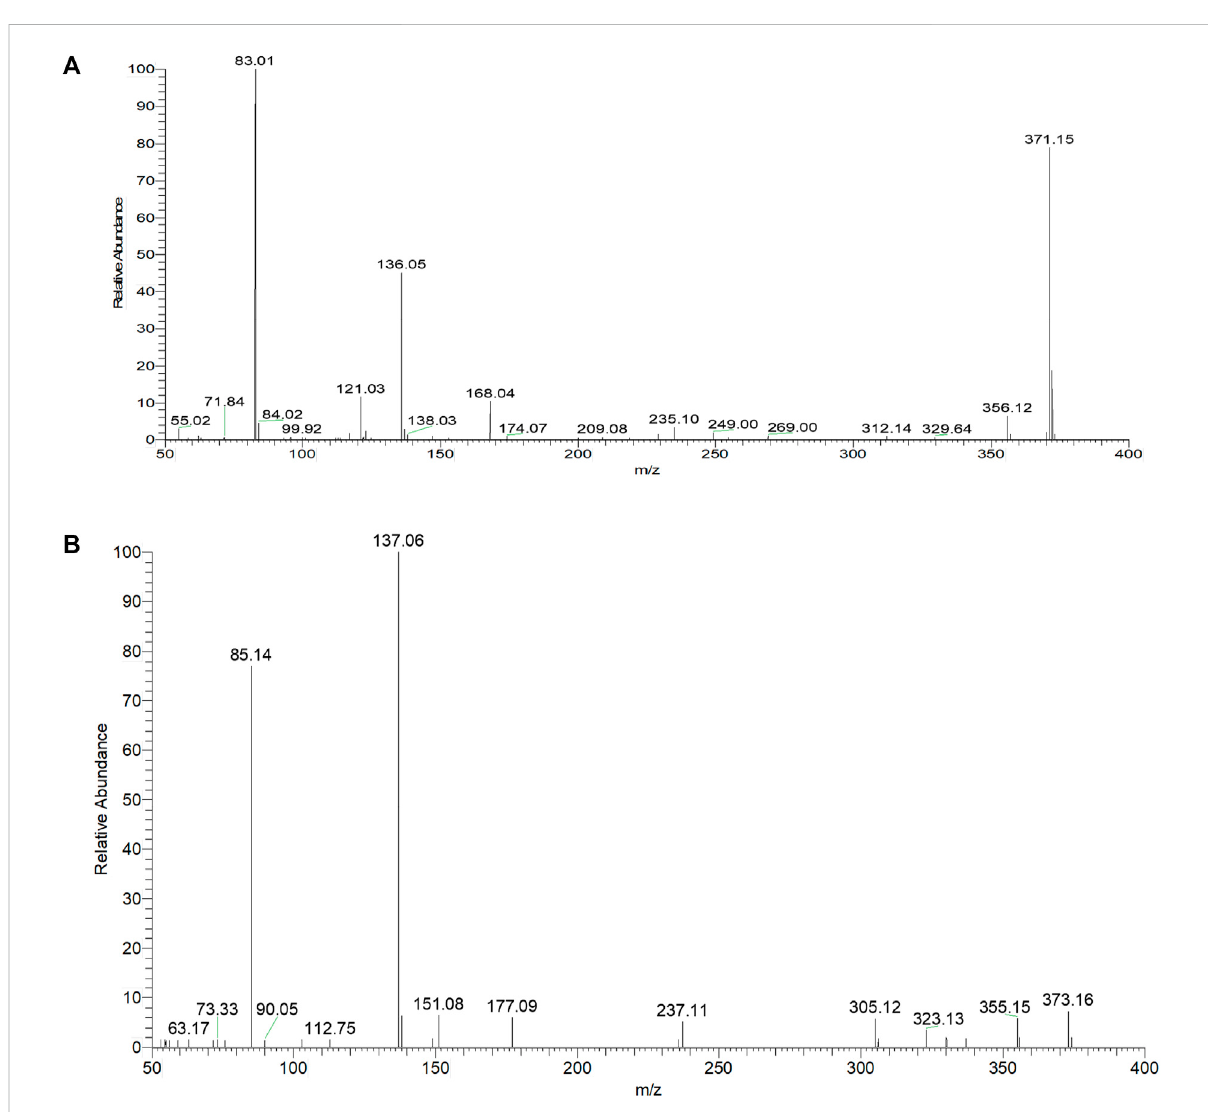
FIGURE 3 The ESI-MS 2 spectra of arctigenin in (A) negative and (B) positive ion